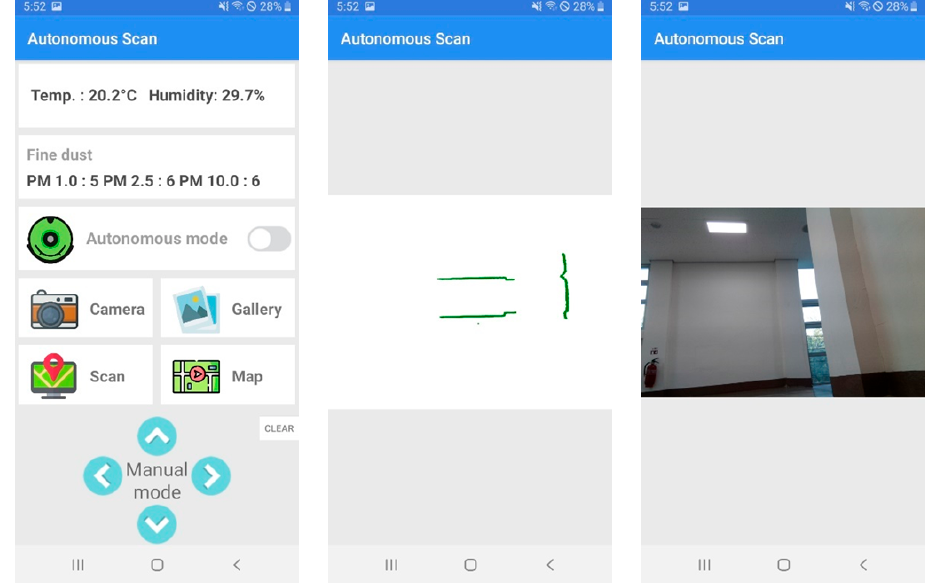
Figure 31. Environmental data result ( left ), captured image ( middle ), and scanned result ( right ) at position (marked 2 in Figure 29) from which third autonomous scanning experiment was performed.